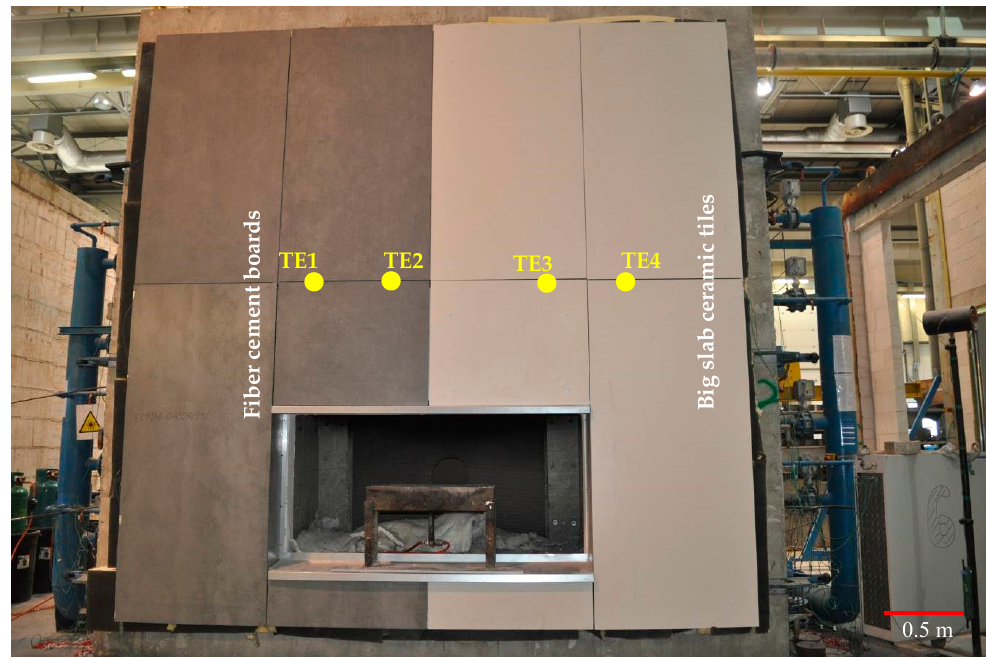
Figure 3. Ventilated facade model with location of thermocouples.